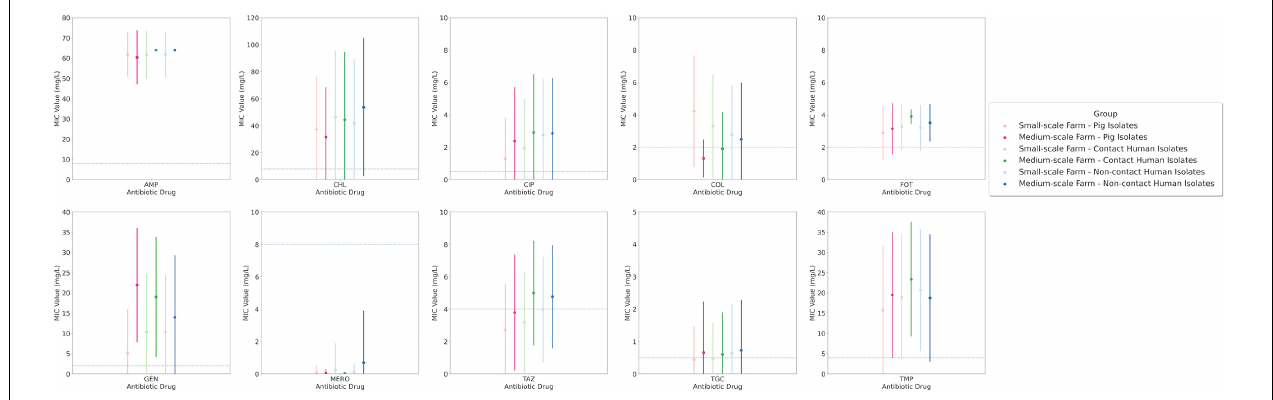
FIGURE 2 | Average Minimal inhibitory concentration (MIC) for drug investigation group to each drug reagent with their respective standard deviation and clinical breakpoints for each drug are displayed across the y -axis.